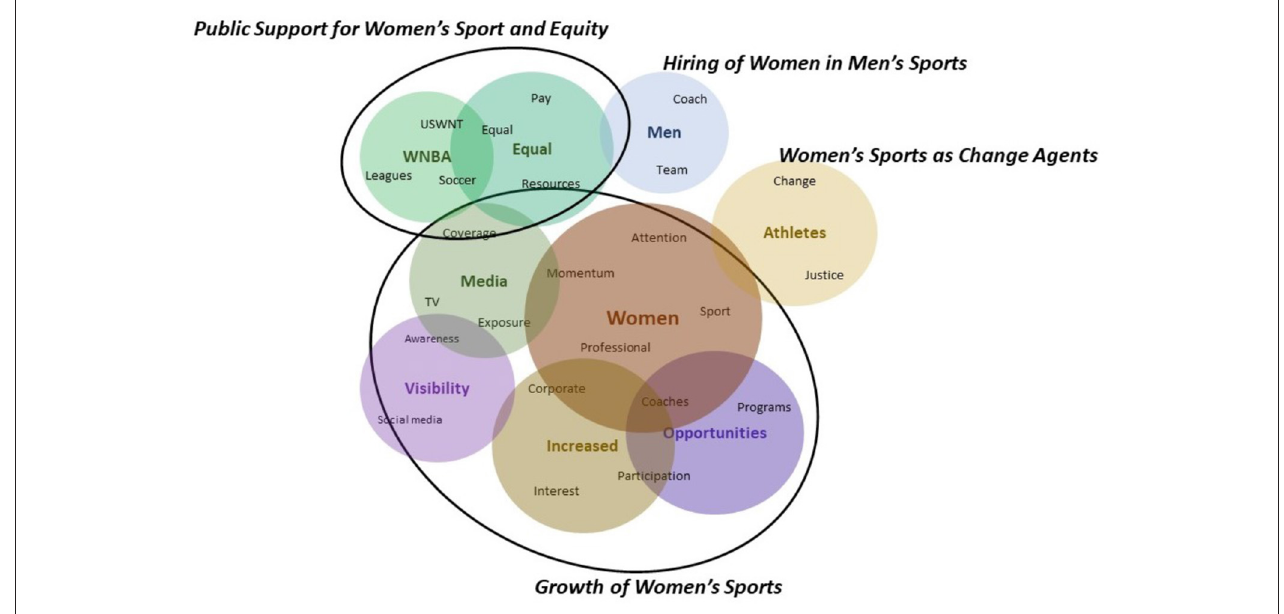
FIGURE 1 | Thematic representation of the frames for question